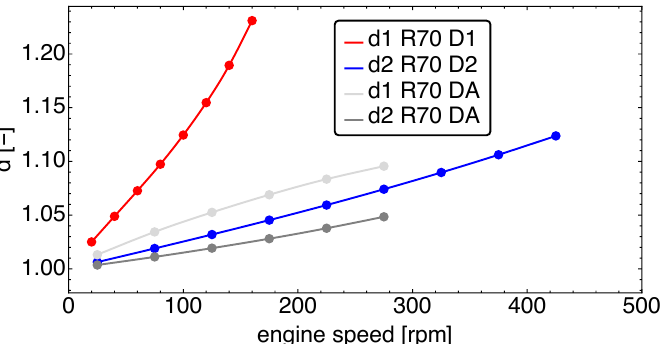
d Figure 6. The displacement ratios d 1 and 2 are shown as functions of the engine speed for the three engine designs D1, D2, and DA, and r = 0.7 regeneration extent. Note the more than linear increase of d 1 for the D1 design.